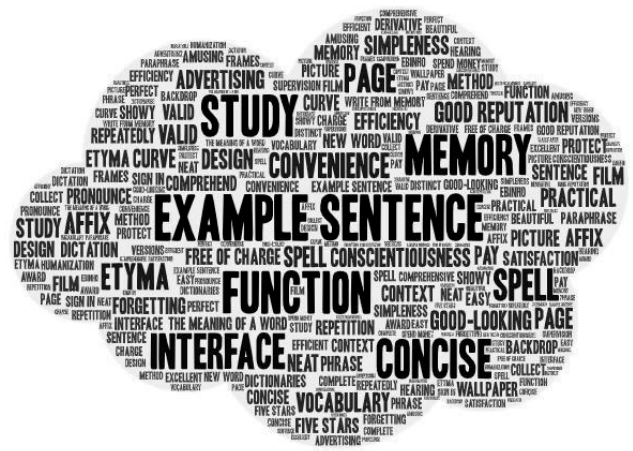
Figure 6. BuBeiDanCi general comment word cloud map.